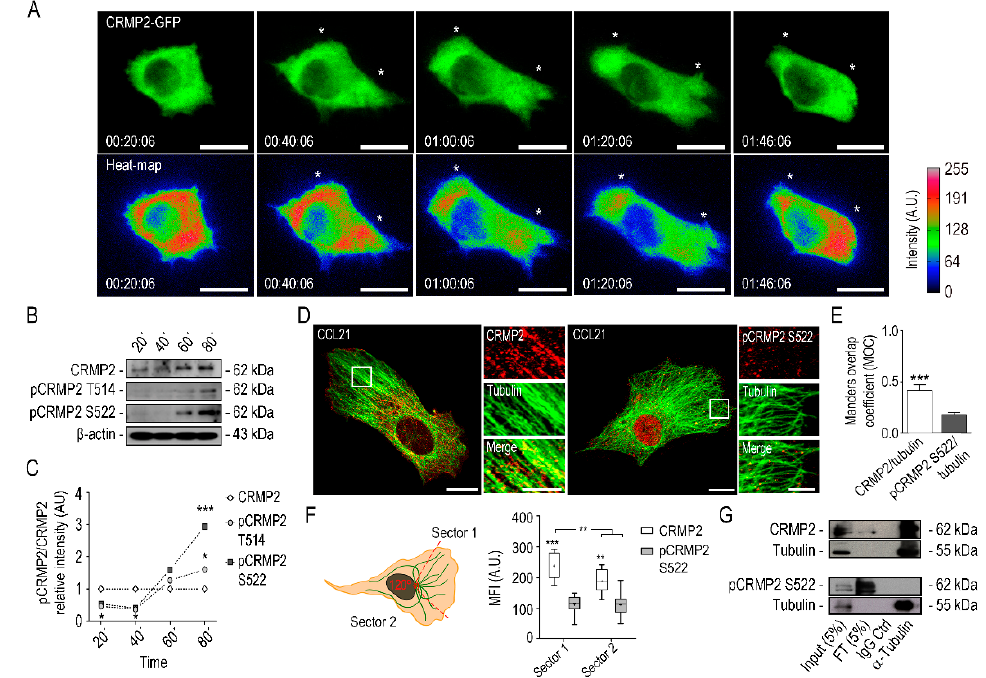
Figure 3. CRMP2 distributes along the lamella of migrating cells. ( A ) Representative confocal images and heat maps of cytoplasmic CRMP2-GFP distribution in A549 cells after CCL21 stimulation (200 ng/mL). Cell migration was captured by confocal video-microscopy with images taken every 2 min for 2 h. Heat maps were rendered using the ImageJ software. White asterisks signal CRMP2 enriched areas at the lamella. Scale bar = 20 microns. (Number of videos, n = 10); ( B ) western blot analysis of CRMP2 and pCRMP2 S522 expression from protein extracts obtained from isolated lamellipodia at the time points indicated. β -Actin was used as a Western blot loading control. (Number of blots, n = 3); ( C ) quantification of CRMP2 and pCRMP2 S522 expression levels from total protein extracts shown in ( B ) (Arbitrary Units, AU). Each sample was normalized to GAPDH expression and, subsequently, to CRMP2 expression; ( D ) representative maximum intensity projections confocal images of actively migrating A549 cells after CCL21 stimulation (200 ng/mL) and stained with specific antibodies to detect tubulin (green), CRMP2 or pCRMP2 S522 (red). Scale bar = 10 microns. White insets show enlarged areas with strong tubulin and CRMP2 or pCRMP2 S522 co-localization at the lamella. Scale bar = 5 microns; ( E ) Manders´ overlap coefficient (MOC) between tubulin and CRMP2 or pCRMP2 S522 positive signal from images shown in ( D ). (Number of images, n = 50); ( F ) quantification of CRMP2 or pCRMP2 S522 distribution in Sector 1 and Sector 2 from images shown in ( D ) following the schema shown on the left. Each cell was segmented into two sectors (120°): Sector 1 comprises the leading edge, and Sector 2 the rear edge. (Number of images, n = 50); ( G ) immunoprecipitation of tubulin and CRMP2 or pCRMP2 S522 from total protein extracts ob- tained from A549 cells after serum stimulation. (Number of blots, n = 3). *** ( p < 0.001). ** ( p < 0.01). * ( p <